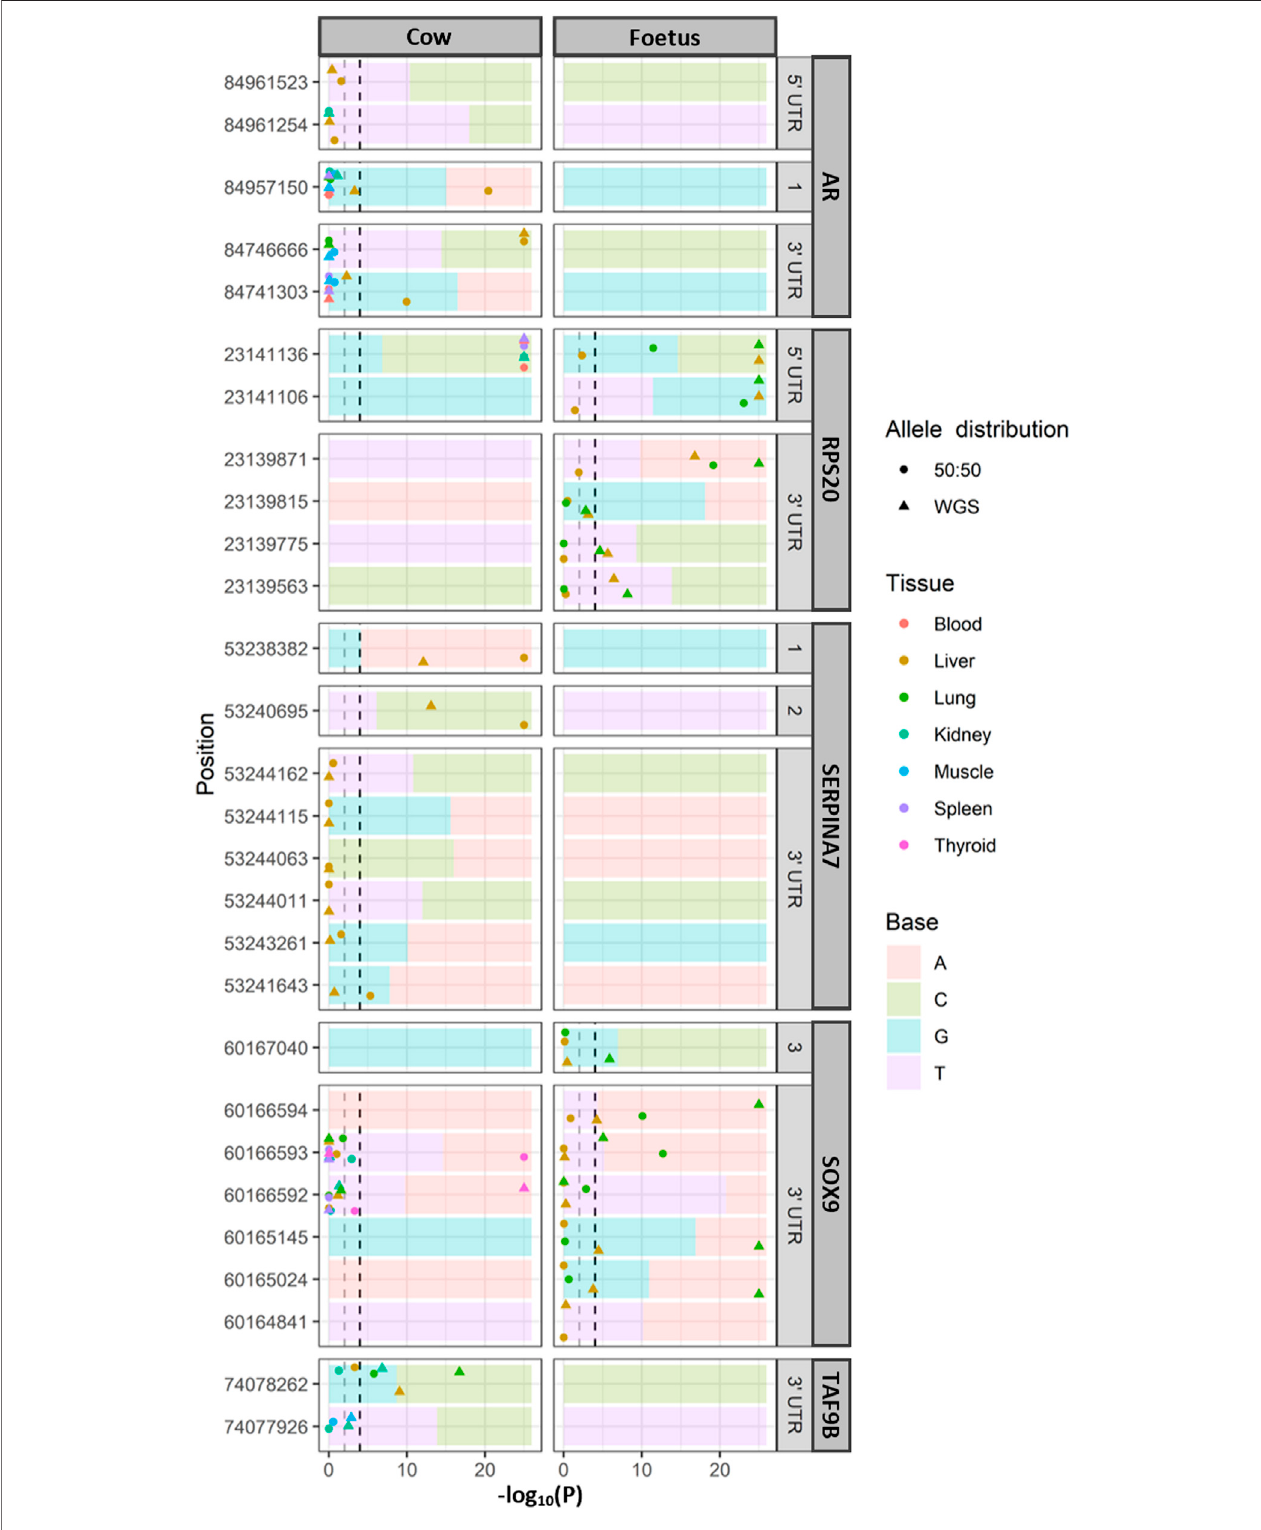
FIGURE 2 | Allele-speci fi c expression for each tissue with signi fi cance. Signi fi cance at p < .0001 and p < .01 indicated for reference (dashed lines). The ratio of alleles observed in whole genome sequencing (WGS) of the same animals is indicated as the background of each panel. Only loci that were heterozygous in the WGS data were tested for allele-speci fi c expression. In the position, 1, 2, and 3 refer to exons 1, 2, and 3, respectively.